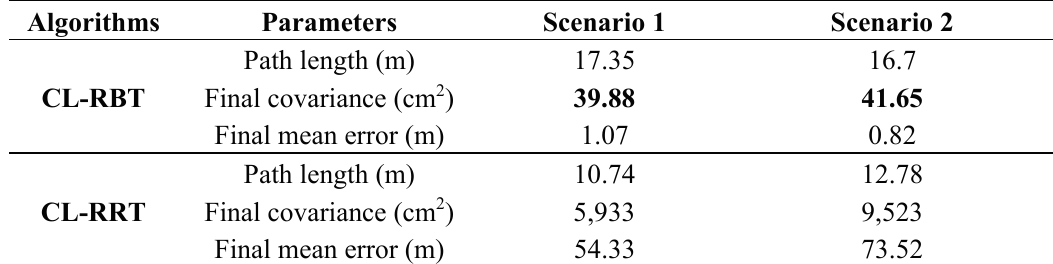
Table 1. Performance comparisons of CL-RBT and CL-RRT, using 30 simulation